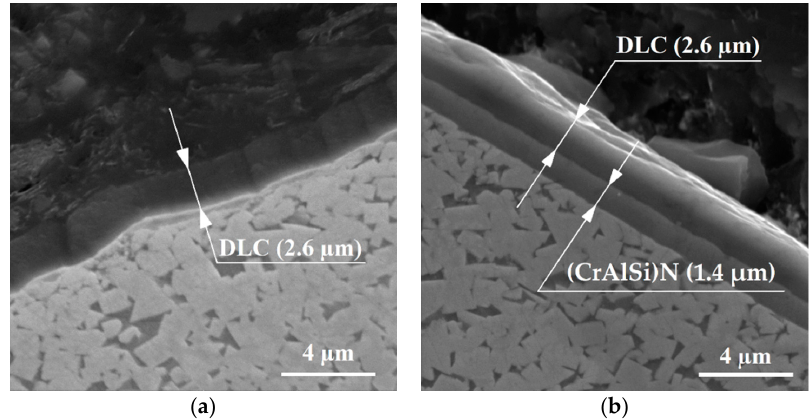
Figure 5. SEM images in secondary electrons of cross-sections of carbide samples, high voltage of 10.0 kV, view field of 16.6 μ m, 25.0 k×: ( a ) single-layer DLC; ( b ) double-layer DLC.